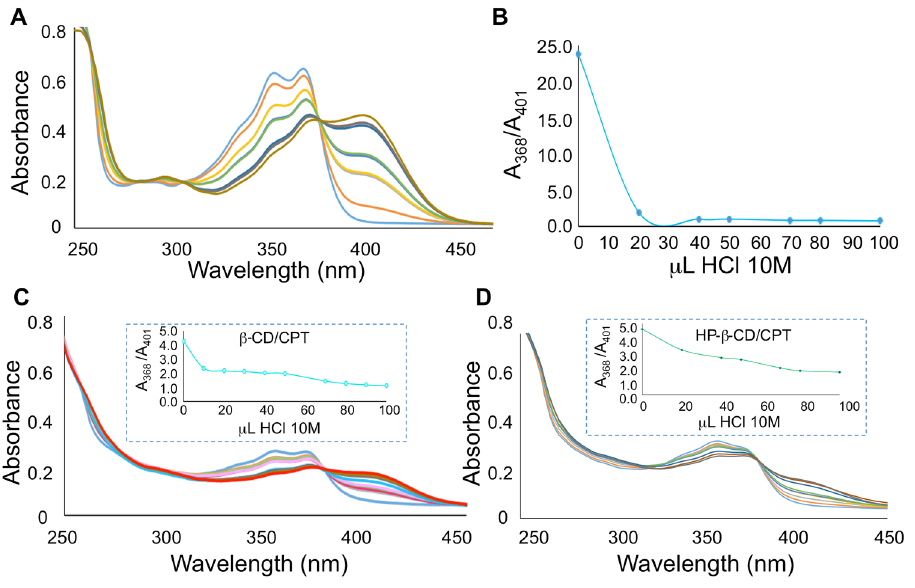
Figure 6. ( A ) Effect of the addition of increasing volumes (10 µ L per addition) of 10 M HCl on the UV-Vis absorption spectra of camptothecin in aqueous solution. ( B ) Ratiometric titration of camptothecin. λ = 366 nm corresponds to the neutral form and λ = 401 nm corresponds to the protonated form. ( C ) Effect of the addition of increasing volumes (10 µ L per addition) of 10 M HCl on the UV-Vis absorption spectra of the camptothecin- β -CD complex in aqueous solution. Inset: Ratiometric titration of the camptothecin- β -CD complex. ( D ) Effect of the addition of increasing volumes (10 µ L per addition) of 10 M HCl on the UV-Vis absorption spectra of the camptothecin-HP- β -CD complex in aqueous solution. Inset: Ratiometric titration of the camptothecin-HP- β -CD